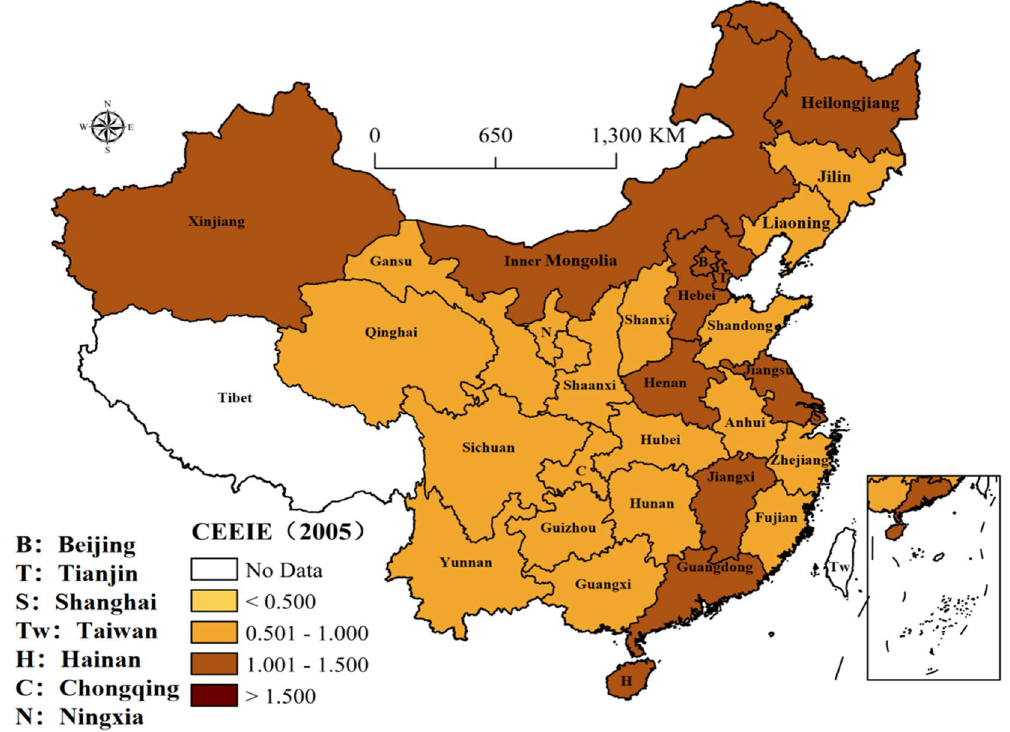
Figure 2. The distribution of CEEIE in 2005 (prepared by KL in ArcGIS Pro, https:// www. esri. com/ zh- cn/ arcgis/ produ cts/ arcgis- pro/ resou rces).